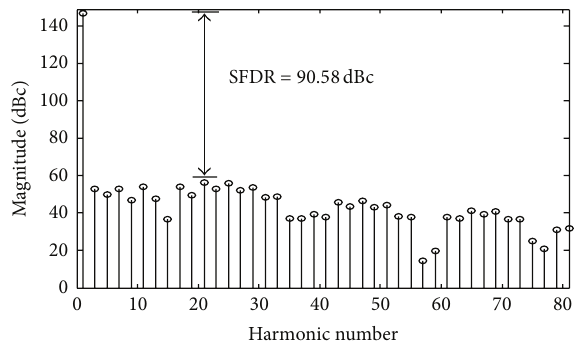
Figure 6: Hybrid polynomial SFDR with digitized optimal coeffi- cients.